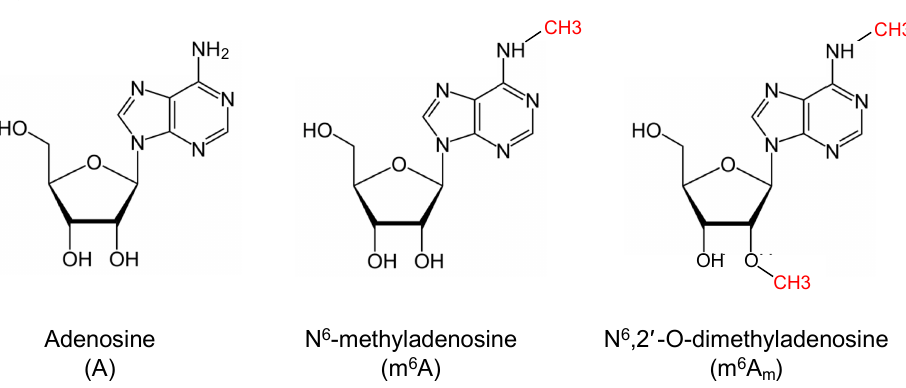
Figure 1. Chemical structures of adenosine (A), N 6 -methyladenosine (m 6 A), and N 6 ,2 ′ -O-dimethyladenosine (m 6 A m ). Methyl groups are indicated in red.